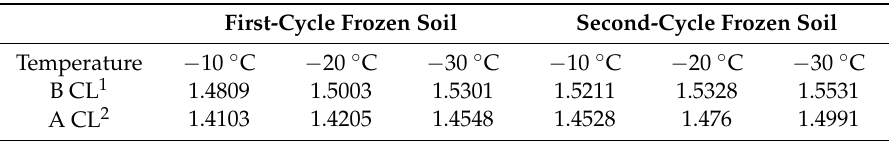
Table 4. Fractal dimension of pores.